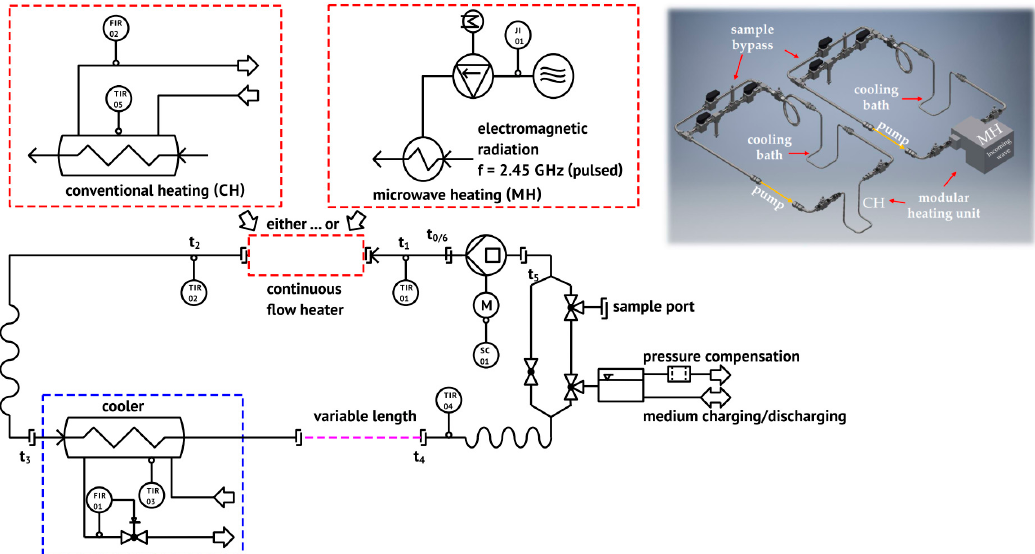
Figure 14. Flowchart of the self-designed, modular lab-scale closed loop system for the inactivation of tumor cell suspension under circulating flow with a modular heating unit: use of conventional warm-water heater (CH, left upper part of the flow chart) and microwave heater (MH, right upper part of the flow chart) and CAD drawing of both heating system (right upper part).